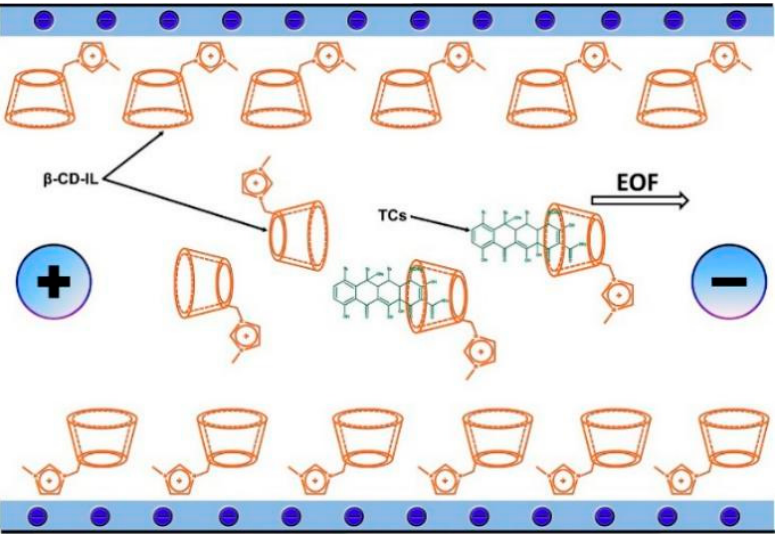
Figure 12. Mechanism of separation of four TCs using β -CD–IL as dynamic coating material. Figure adopted with permission from [63]. Figure adopted with permission from